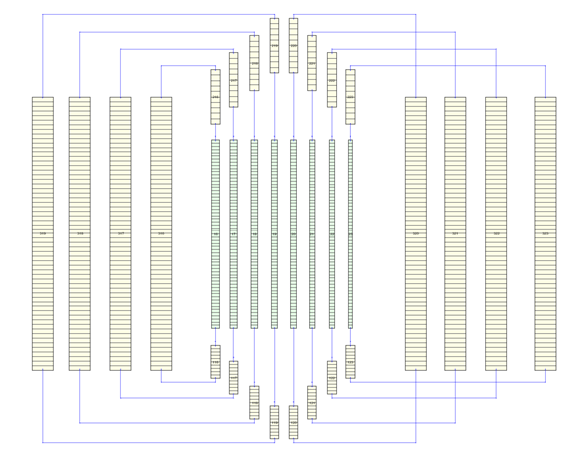
Figure 3. TRACE model with green pipes connected to heatstructures, set of pipes serving as bottom and top plenum, and set of pipes serving as a reactor